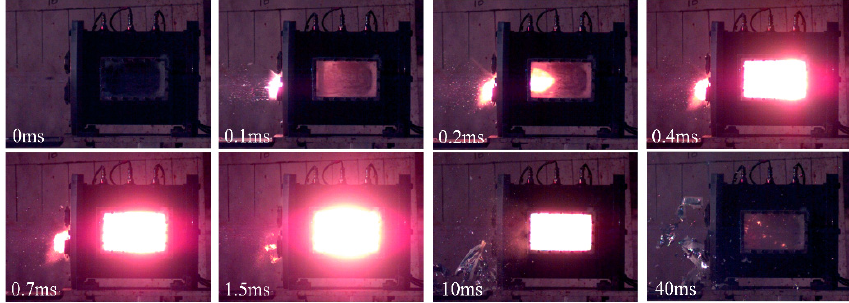
Figure 4. Typical shock-induced reaction phenomena (PTFE/Al/MoO 3 , 910.45 m/s).